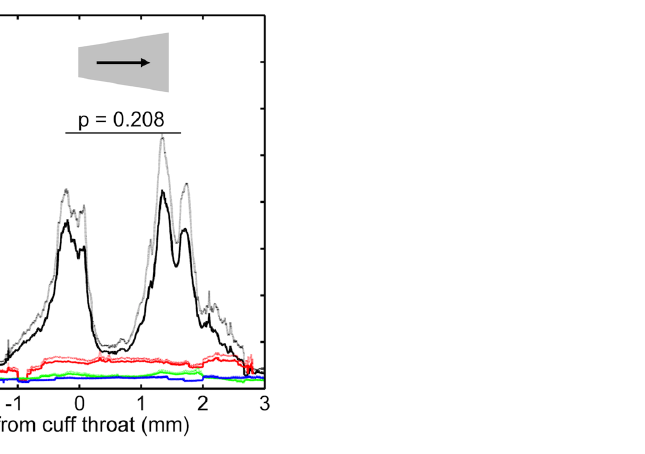
Fig. 11. Tracer uptake along vessels along vessels with the cuff in the reverse orientation. A plot equivalent to Fig. 10 but for mice with the cuff in the reverse direction; n 5 8 for tracer and n 5 7 for autofluorescence.